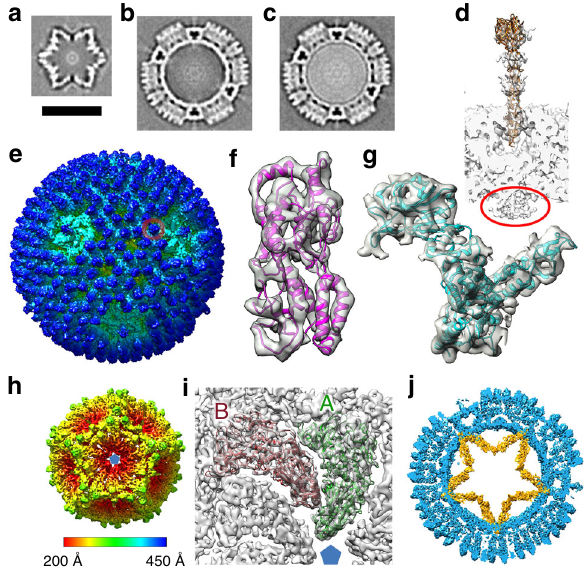
Fig. 2 Sub-tomogram averaged reconstructions. a – c Overviews of sub- tomogram averaging of stars, empty- and full virion-like particles respectively using IMOD/PEET 32 . Scale bar length 500 Å. d Cross-section through the fi vefold of map ( b ). Circled in red is density attributed to the polymerase. The σ 1 spike protrudes from the surface (a σ 1 trimer is fi tted). e Surface rendering of the emClarity map for the empty virion-like particle coloured by radius (scale bar as for panel h), a σ 3/ μ 1 heterohexamer is circled in red. f , g Fits of the models (see “ Methods ” ) into the empty virion- like particle pseudo sixfold emClarity map, σ 3 in purple, μ 1 in cyan. h , i emClarity SLP map. h Coloured by radius. i Fit of λ 1 subunits into the density, molecules A and B coloured green and red respectively. j Slice through the superposed sub-tomogram averaged emClarity maps; empty virion-like particle in blue and SLP in orange. The data were taken from fi ve tomographic series (selected from 8 in total). Information on the number of particles used is given in Supplementary Table